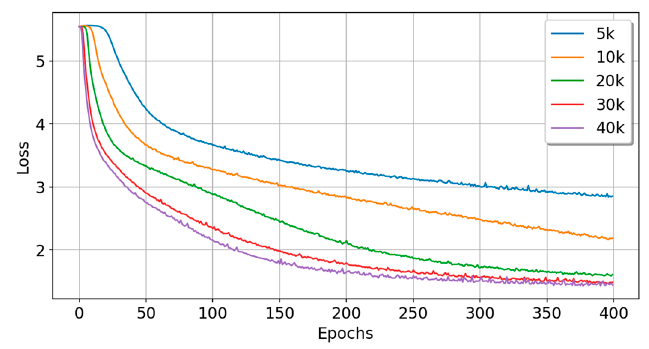
Figure 22. CNN loss values under different scales of data.